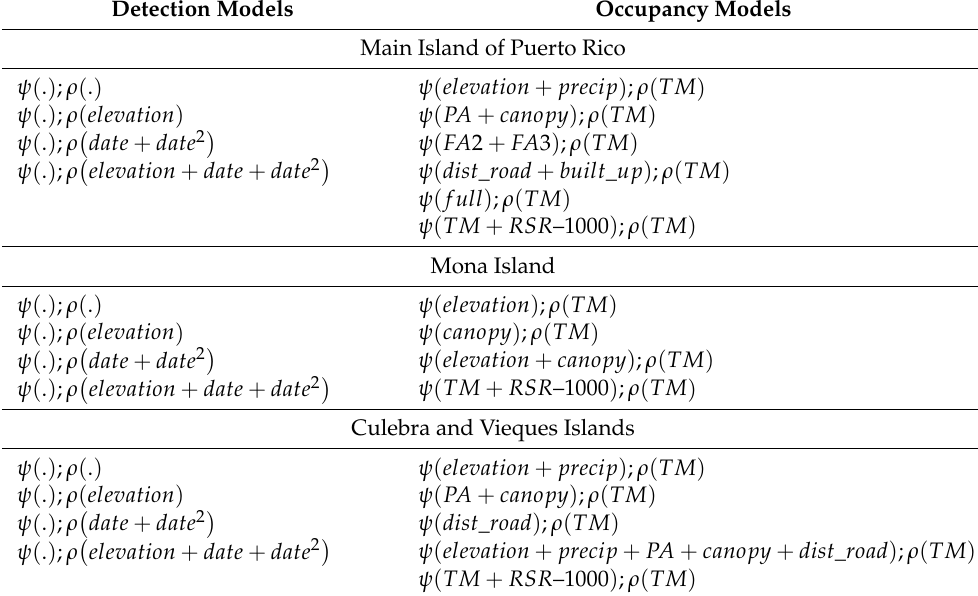
Table 1. A priori candidate models fitted in the occupancy analyses for the main island of Puerto Rico and Culebra, Mona, and Vieques. TM = top model; precip = precipitation (cm); PA = proportion of protected area; canopy = proportion of canopy cover; date = Julian date (we considered Julian day 1 as the first day of a device starting to record in the field, which was 1 March 2021); date 2 = square of Julian date; fa2 = proportion of forest cover aged between 32 and 54 years; fa3 = proportion of forest cover older than 54 years; dist_road = distance from roads (m); built_up = built-up proportion; RSR = restricted spatial regression. We considered a distance threshold of 1000 m for two sites to be considered a neighborhood in the spatial occupancy